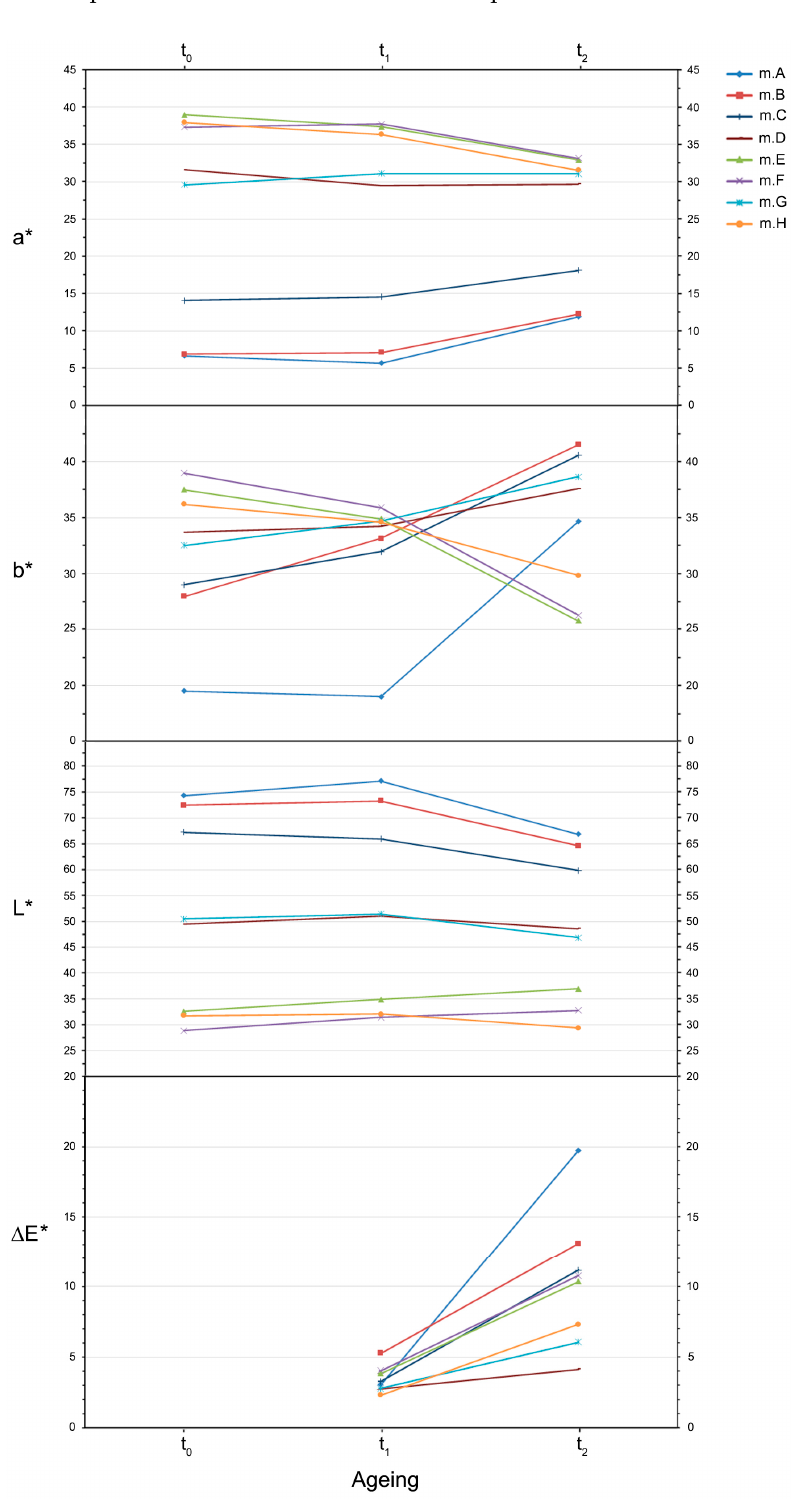
Figure 12. L *, a *, b * coordinates of the mock-ups as a function of the aging time. The calculated values Δ E * t 1– t 0 and Δ E * t 2– t 1 are reported in correspondence with the x-axis labels t 1 and t 2 , respectively.